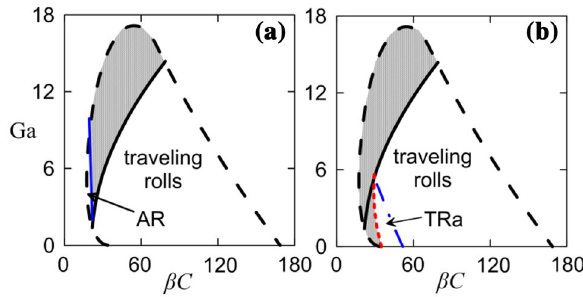
Fig. 4 Selection of oscillatory patterns in a thin film heated from below ( a ) on a square lattice and ( b ) on a hexagonal lattice. Domains of stability for alternating rolls and traveling rectangles are marked by “AR” and “TRa,” respectively. The domains of subcriti- cality are shaded. The dashed line outlines the area where the oscil- latory mode is critical. [28,